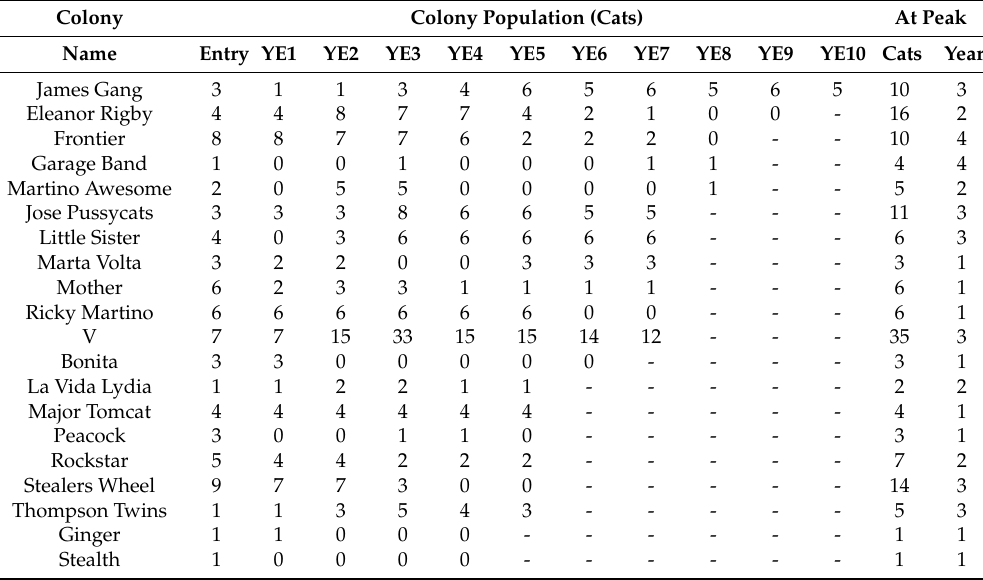
Table 1. Colony size at entry, year-end follow-ups, and at peak.